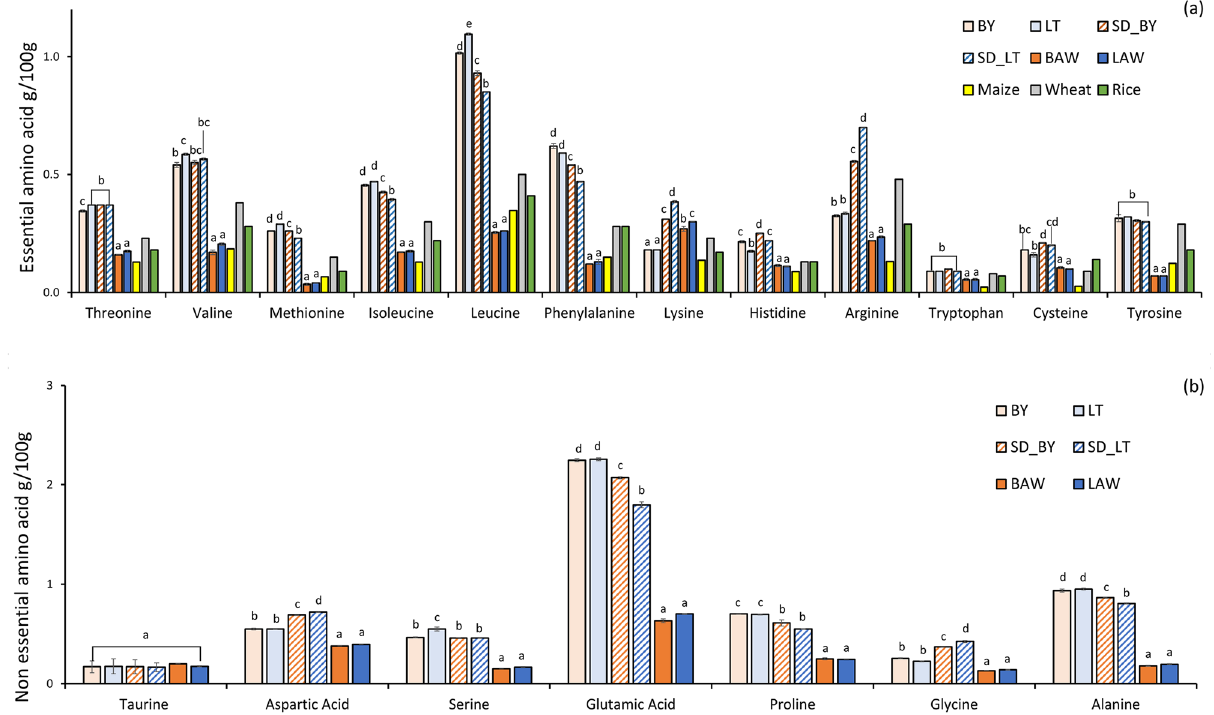
Figure 4. Amino acid profile of AWM sample and millet flour samples compared to popular cereal grains. W/W% = grams per 100 g of sample. The data for maize, wheat, and rice was obtained from Chandra et al. 38 . Mean values followed by a different letter are significantly different. Legend: Amino acid profile of powder samples. BY: plain Barnyard millet flour; LT: plain Little millet flour; SD_BY: spray dried Barnyard millet soluble fraction; SD_LT: spray dried Little millet soluble fraction; BAW: 25% w/v Barnyard millet + acid whey; LAW: 25% w/v Little millet + acid